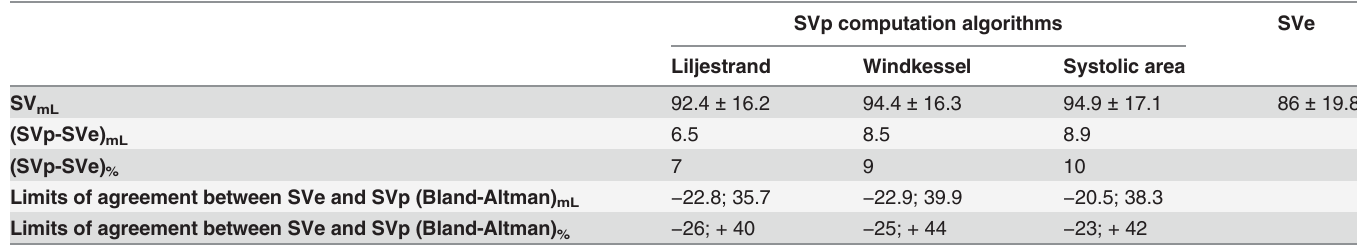
Fig 2. Time course of cardiovascular parameters measured by or computed from finger arterial blood pressure (ABP). Parameters measured: SAP, systolic arterial pressure; DAP, diastolic arterial pressure; Parameters computed: HR, heart rate; SV, stroke volume; CO, cardiac output. doi:10.1371/journal.pone.0121936.g002 Comparison between methods Intra-class correlations between SVe and SVp and 95% confidence intervals (ICC (CI 95%)) were 0.71 (0.54 – 0.81) for Liljestrand, 0.68 (0.47 – 0.80) for Windkessel and 0.70 (0.50 – 0.81) for the systolic area method. The correlation between SVp and SVe (Figs. 7 – 9) was significant for the three algorithms (p < 0.001). The correlation coefficient was 0.67 for Liljestrand, 0.62 for Windkessel and 0.68 for the systolic area method. Regression slopes did not differ from the equality line for all three algorithms (Liljestrand, F(1,60) = 1.36, p = 0.24; Windkessel, F(1,60) = 2.38, p = 0.13; systolic area, F(1,60) = 2.22, p = 0.14). However, Y-axis intercepts were different for the three Table 1. Mean differences and limits of agreement for the Bland-Altman